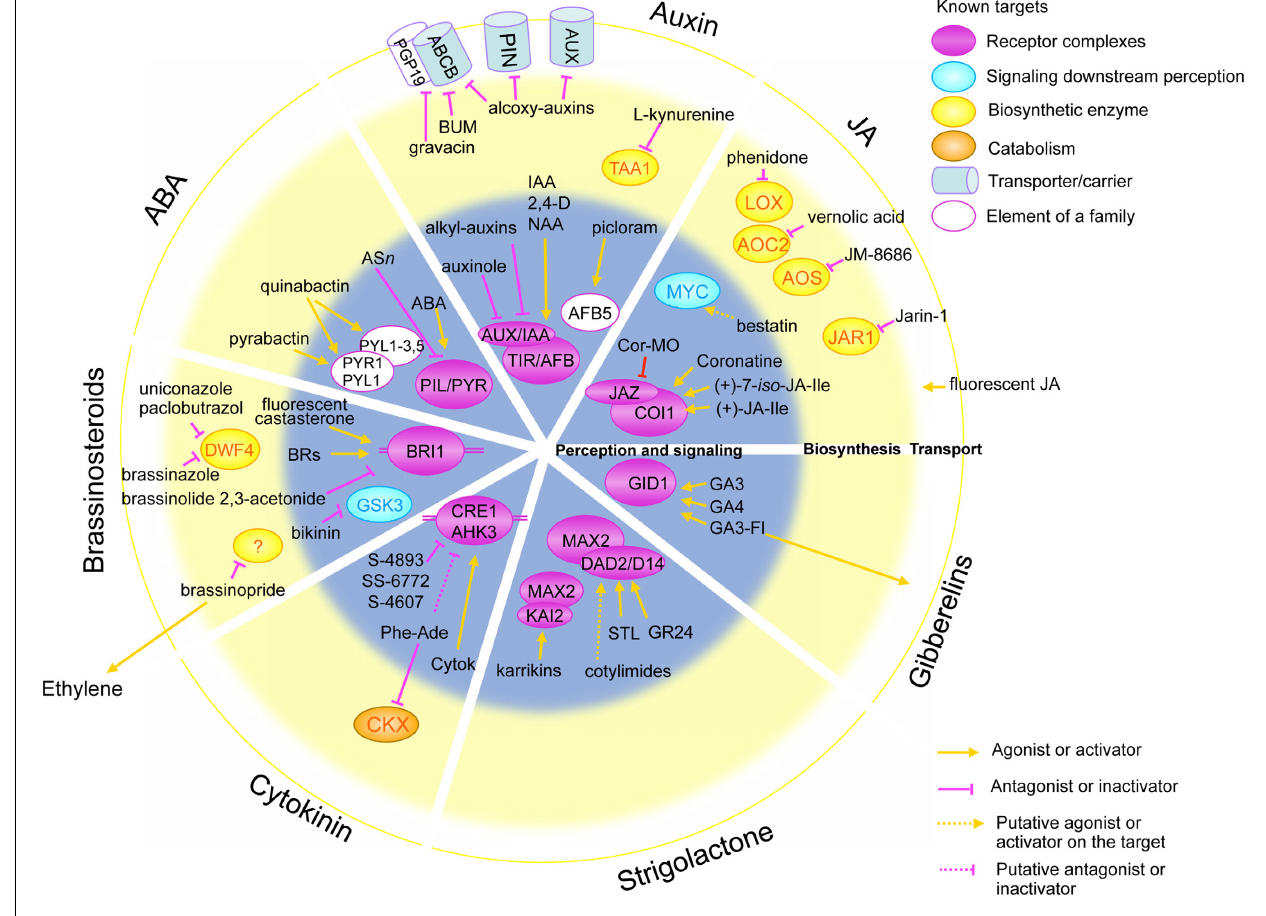
strigolactones, cytokinins, brassinosteroids and abscisic acid (ABA). Ovals represent the molecular targets: receptor complexes (violet), signaling components (blue), biosynthetic enzyme (yellow) and catabolic enzymes (orange). Cylindrical shapes represent transporters and carriers. Molecules acting as activators are represented with an orange arrow toward their targets, whereas pink blocked arrows highlight antagonists and inhibitor